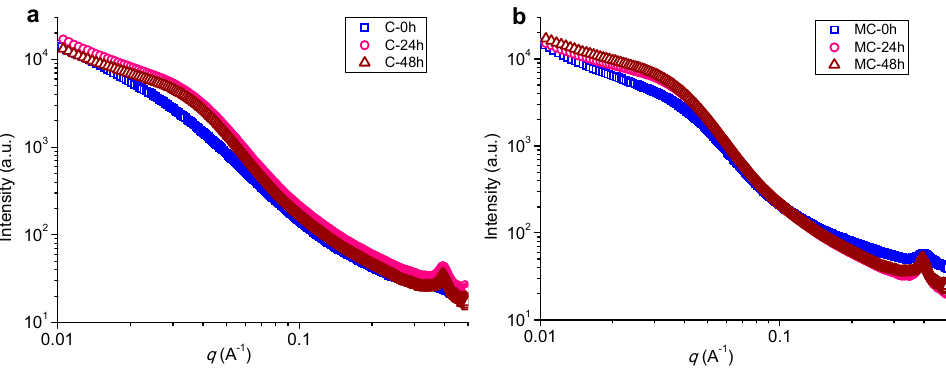
Figure 2. SAXS curves of conventionally (C) ( a ) and microwave-cooked (MC) ( b ) starches with different storage times (0, 24, or 48 h).